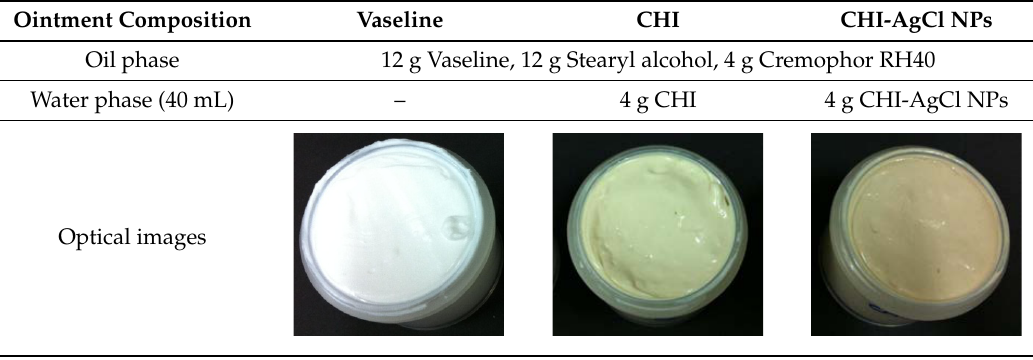
Table 1. The composition of each ointment for in-vivo burn wound healing in the rats.